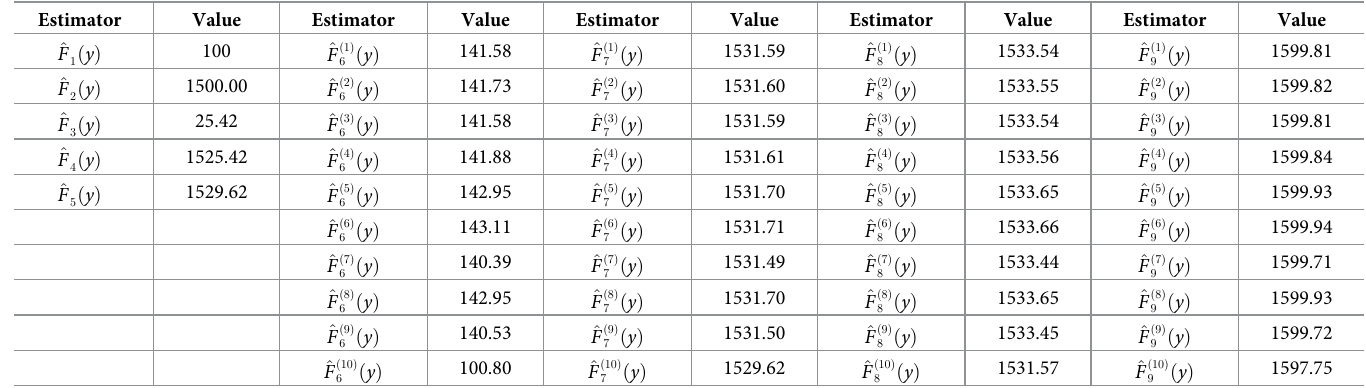
Table 6. PREs of distribution function estimators using Population IV. Estimator